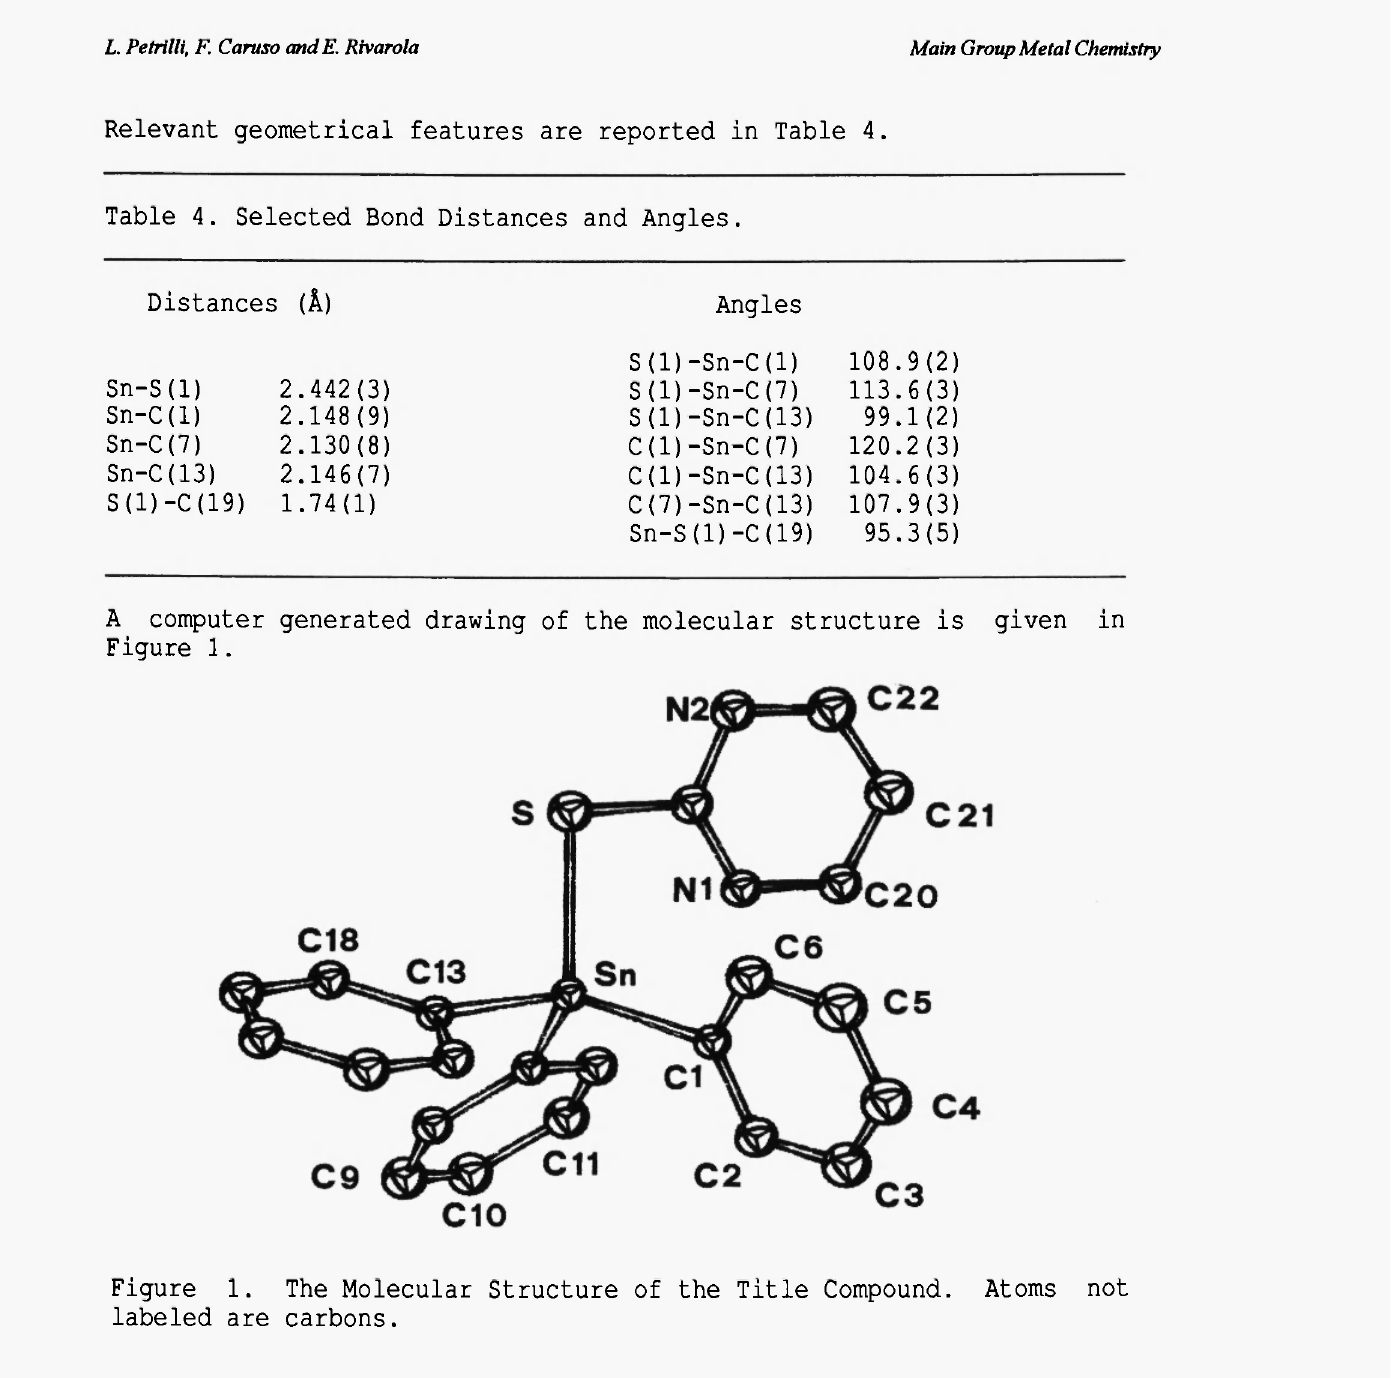
Figure 1. The Molecular Structure of the Title Compound. Atoms not labeled are carbons. The metal coordination can be described as tetrahedral with three carbons from each the three phenyls and the sulfur atom of the pyrimi- dine-2-thionato moiety. This ligand has two nitrogens available for